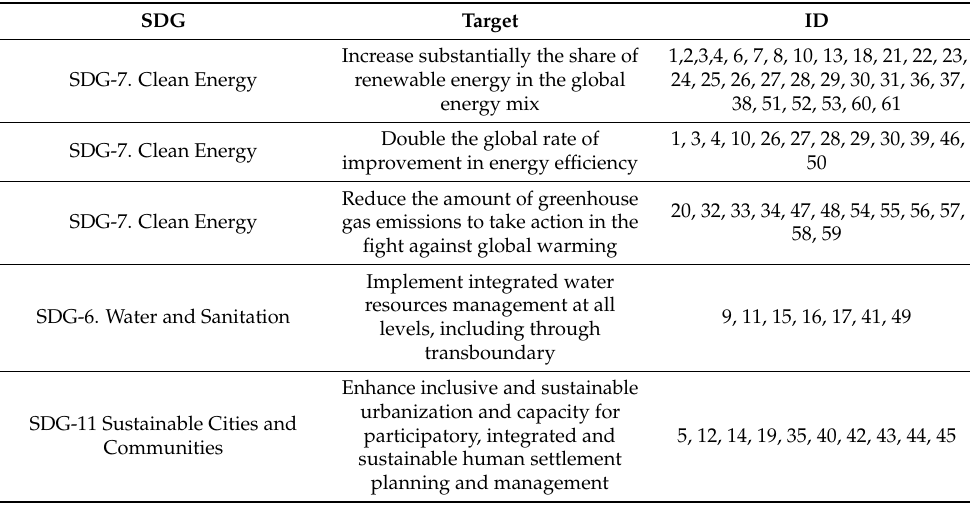
Table 5. Summary of study cases emphasizing SDGs. SDG Target